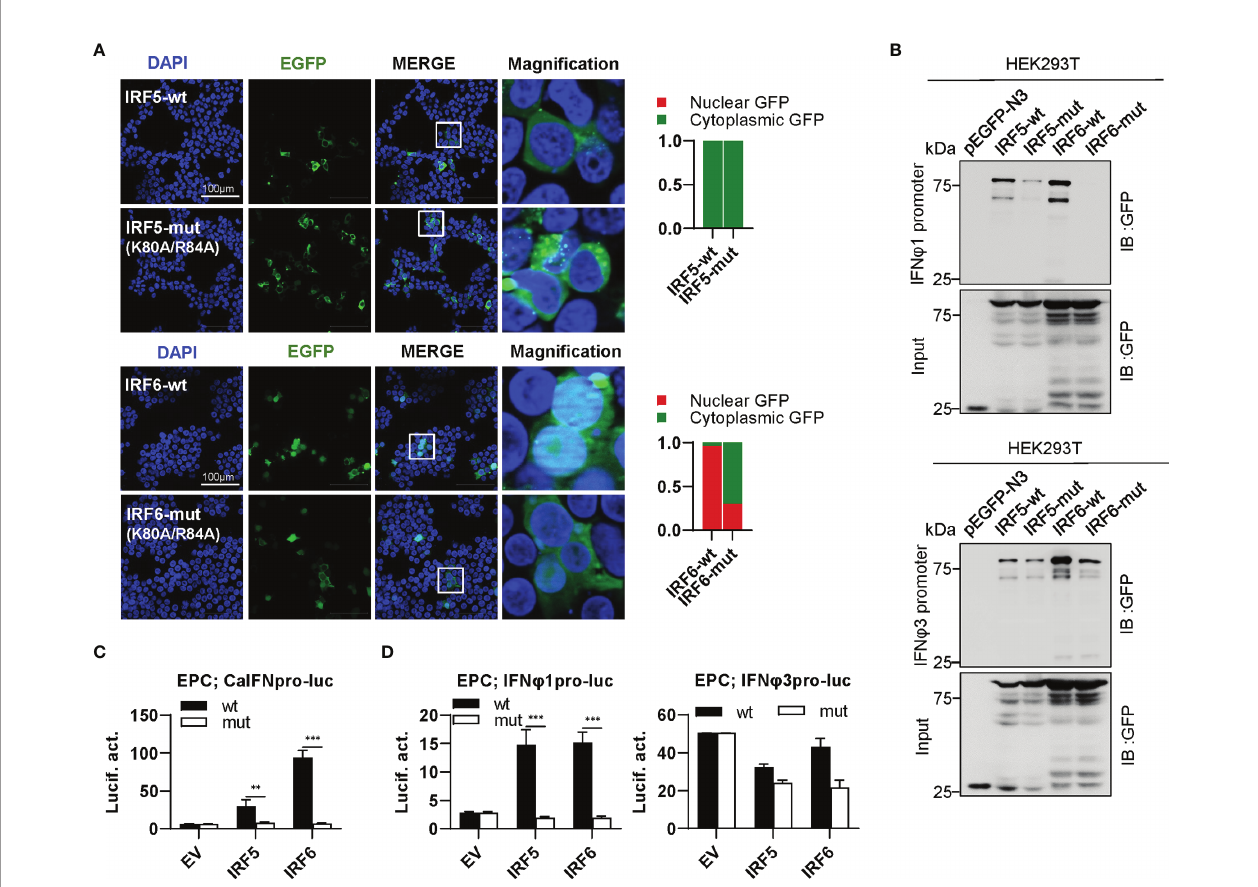
FIGURE 8 | The two basic residues are essential for IRF5/6 to regulate IFN response. (A) Mutation of the two residues impaired the constitutively nuclear accumulation of IRF6 but not of IRF5. Left panels: HEK293T cells seeded overnight on microscope slide cover-glasses in six-well plates were transiently transfected as in Figure 4 , with indicated plasmids (2 m g each) for 24h, followed by confocal microscopy examination. The last column showed magni fi cation view of the area highlighted in the box. Right panels: The intensities of nucleus/cytoplasm GFP were quantitated using the ImageJ processing program and normalized to that of the empty construct pEGFP-N3, which was set to 1:1. (B) Pull-down analysis of the binding af fi nity of wild types and mutants of IRF5/6 to IFN j 1/IFN j 3 promoters. DNA pull-down assays were performed as in Figure 3B , by incubating biotin-labeled IFN j 1 or IFN j 3 promoter DNA with appropriate amounts of HEK293T cell lysates, where cells were transfected for 30h with wild types or mutants of IRF5/6, respectively. (C, D) . IRF5/6 mutants failed to stimulate the activation of crucian carp IFN promoter (C) , and zebra fi sh IFN j 1/IFN j 3 promoters (D) . EPC cells seeded in 48-well plates overnight were transfected with CaIFNpro-luc (C) , IFN j 1pro-luc or IFN j 3pro-luc (D) , together with the indicated IRF plasmids (100ng each). 30h later, cells were harvested for luciferase assays. (***P < 0.001; **P <